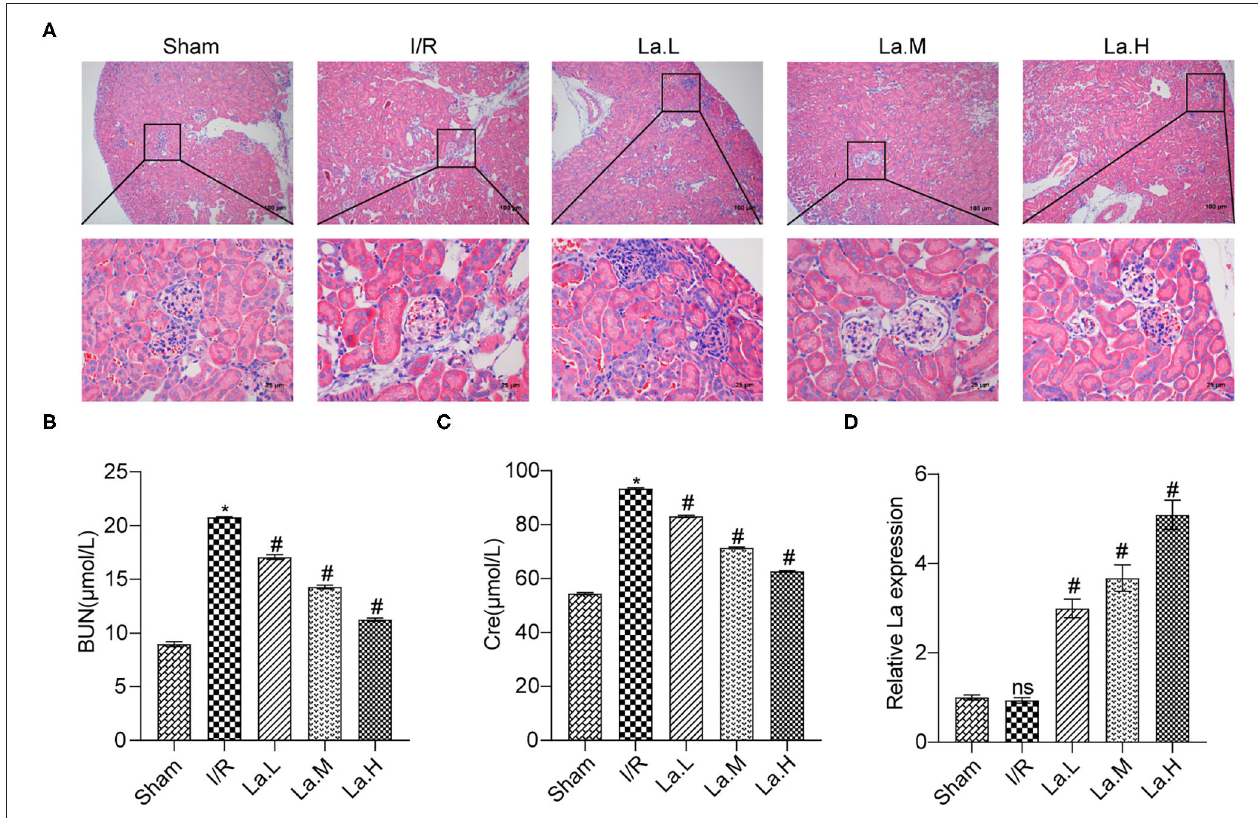
FIGURE 1 | Lactobacillus acidophilus ATCC 4356 relieved renal injury in mice with ischemia/reperfusion (I/R). (A) The kidney tissue damage was observed by H&E staining in each group. (B) L. acidophilus ATCC 4356 reduced serum blood urea nitrogen (BUN) expression in I/R mice. (C) L. acidophilus ATCC 4356 decreased serum creatinine (CRE) expression in I/R mice. (D) L. acidophilus ATCC 4356 was colonized in the intestine of I/R mice. All data are expressed as mean ± standard deviation. All experiments were repeated three times independently. Statistical significance was calculated using one-way analysis of variance. * p < 0.05 vs. Sham, # p < 0.05 vs.